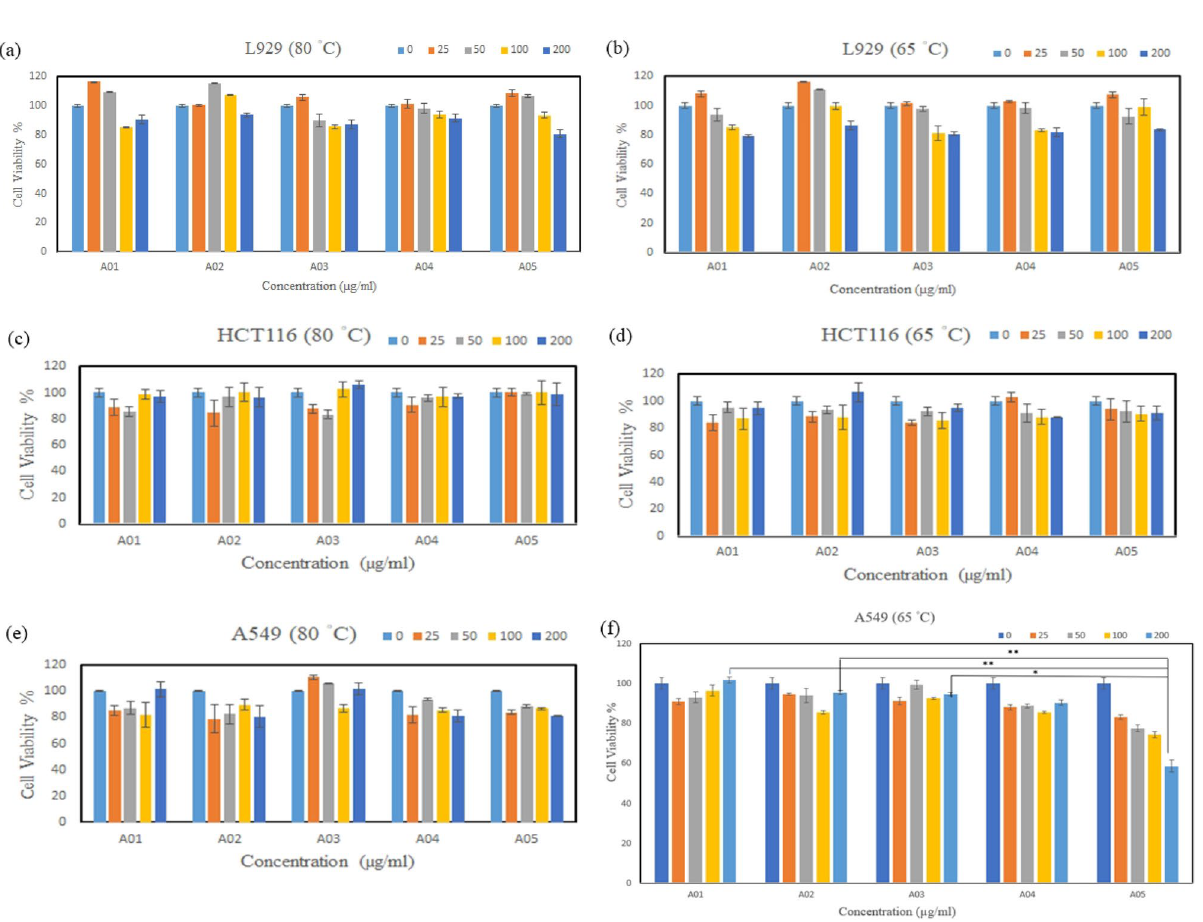
Figure 6. Fucoidan of S. ilicifolium from different locations that was extracted at ( a ) 65 °C and ( b ) 80 °C on the cell viability of the L929 ( a ) ( b ), HCT116 ( c )( d ) and A549 ( e )( f ) cell lines. Bars indicate SD, n = 3. (** P < 0.01 and * P <